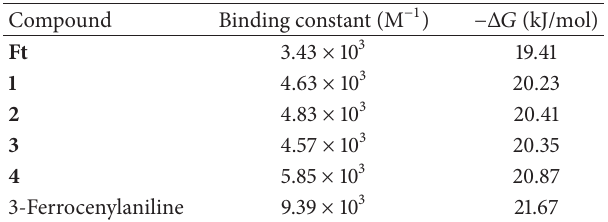
Figure 3: Cyclic voltammograms of 1mM compound 4 recorded at 100 mV/s potential sweep rate on glassy carbon electrode at 25 ∘ C in the absence (a) and presence of 1mL of 20 𝜇 M, 40 𝜇 M with increasing concentration of CT-DNA (b-c) in 20% aqueous DMSO buffer at pH 7.0; supporting electrolyte 0.1M KCl. Table 1: Binding constant and binding energy values of 1–4 and 3- ferrocenylaniline [17].